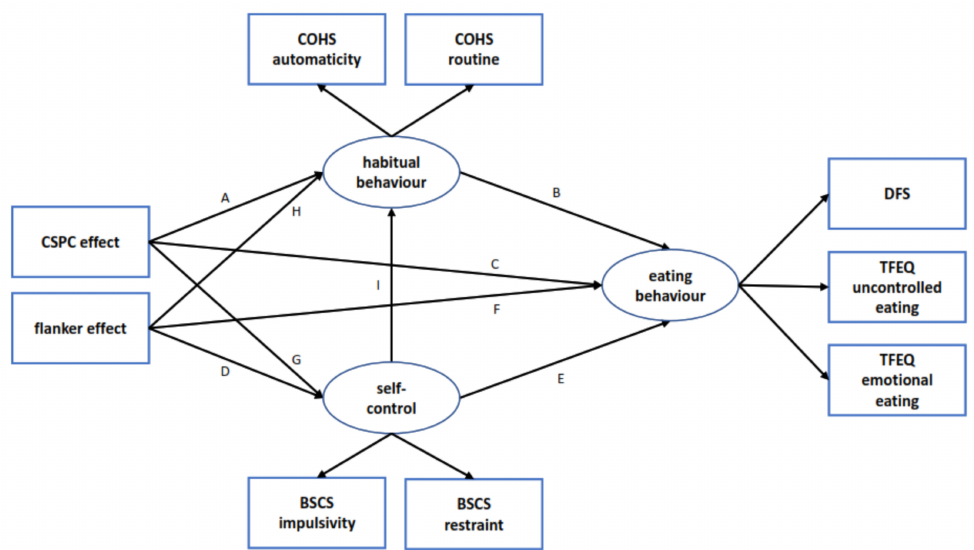
Figure 2. Visual representation of the structural equation modeling (SEM) analyses. Via nested model comparison, a full model (complex model B) was compared to a slightly simpler model (complex model A, paths C and F dropped) and a baseline model (paths C, F, G, H, I dropped). CSPC = context-specific proportion congruent, COHS = Creature of Habits Scale, BSCS = Brief Self-Control Scale, DFS = Dietary Fat and Free Sugar Short Questionnaire, TFEQ = Three Factor Eating Questionnaire.